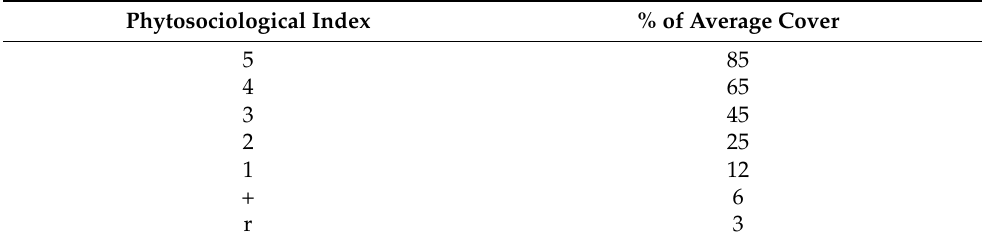
Table 2. Conversion of the values of the phytosociological indices and their correspondence with the average percentage cover values. The non-numerical values (“+” and “r”) have been transformed and estimated by interpolation from the numerical indices (the transformation of the phytosociological are according to